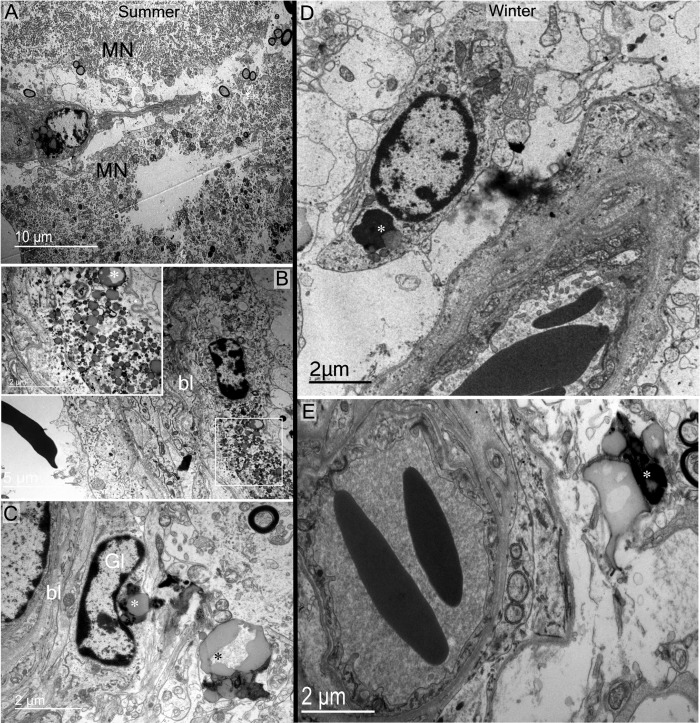
Debris material in perivascular zones of the supraoptic nucleus observed in summer and winter seasons.A-B) Cytoplasmic recycling material is observed in perivascular cells of the somatic zone. (C-E) Debris bodies (asterisks) are also found close to capillaries, engulfed or inside glial cells (Gl). bl: basal lamina; MN: magnocellular neurone.